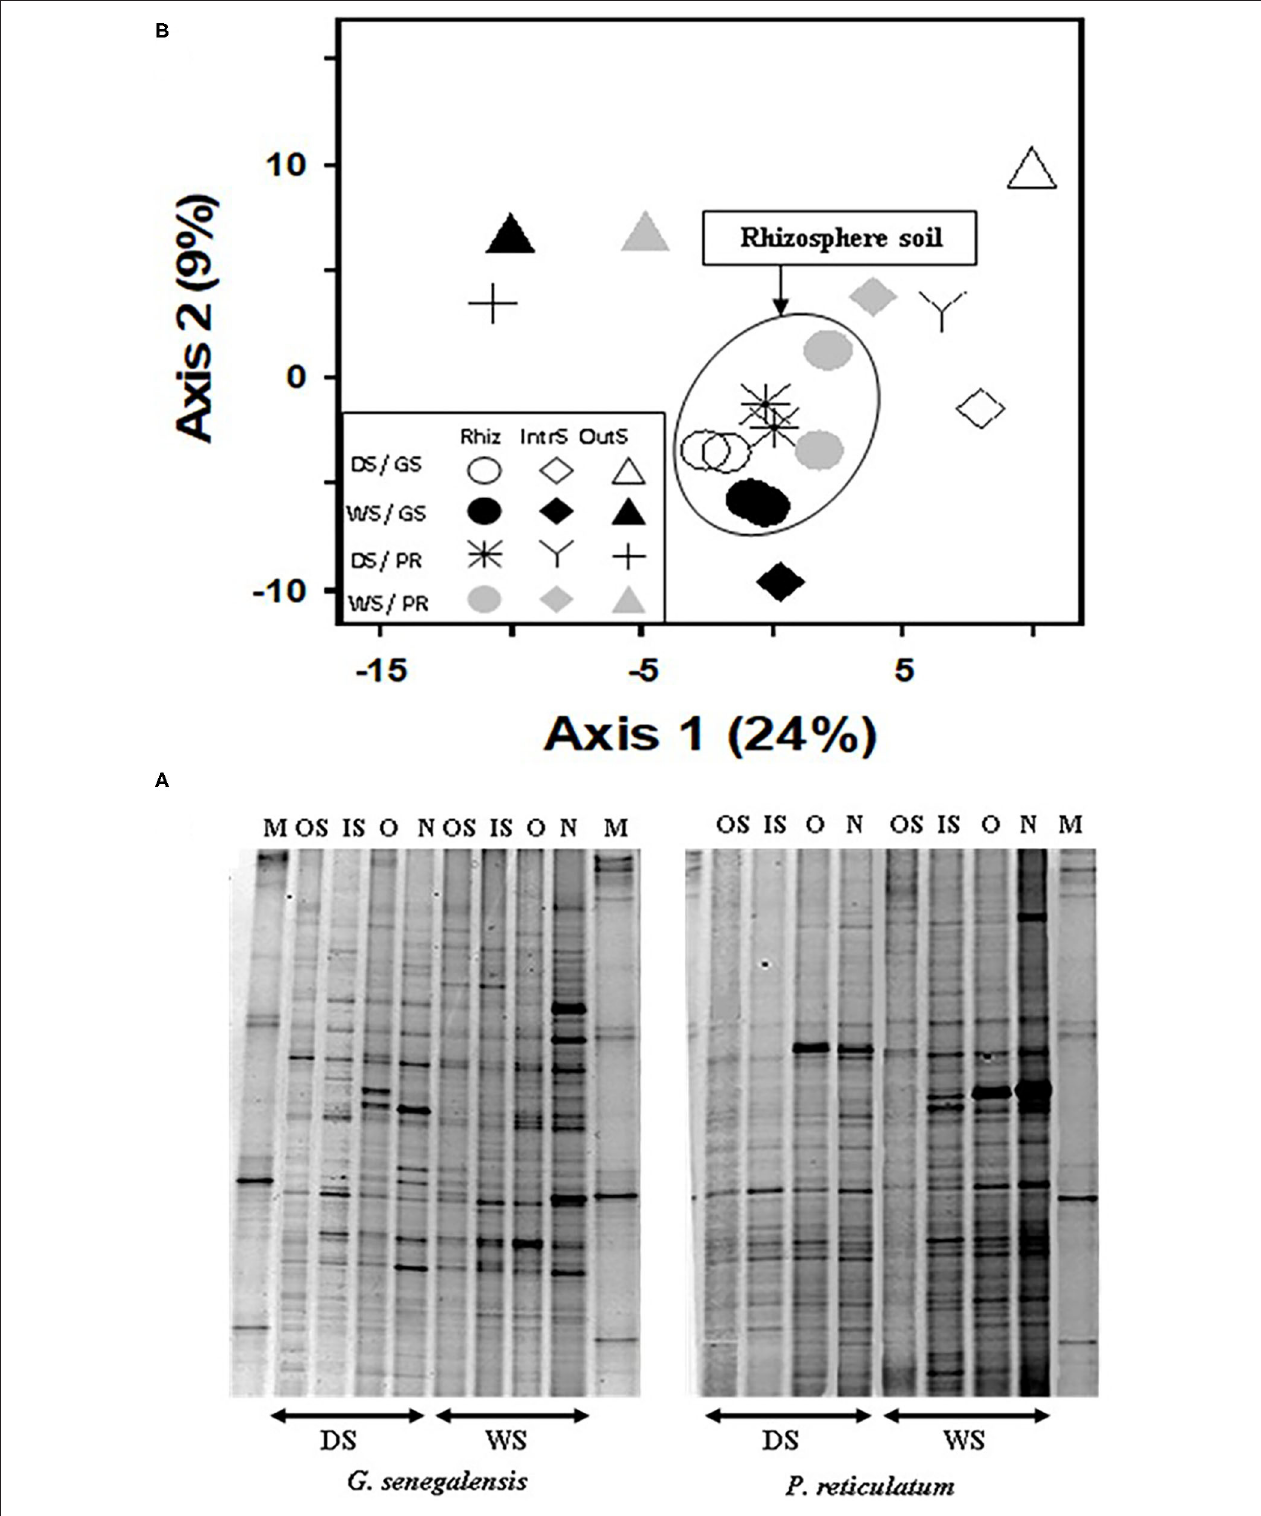
FIGURE 4 | (A) Bacterial DGGE profile of 16S rDNA PCR product extracted from soil, and (B) PCA ordination analysis of DGGE banding profiles. Samples are from the wet (WS) and dry season (DS) in two sites with G. senegalensis (GS) and P. reticulatum (PR) shrubs. In DGGE gel image M, marker; OS, outside the influence of shrub soil; IS, inter-root soil; O, old roots; and N, new roots. In PCA plot RhizS, shrub rhizosphere soil; IntrS, inter-root soil; and OutS, outside the influence of shrub soil.